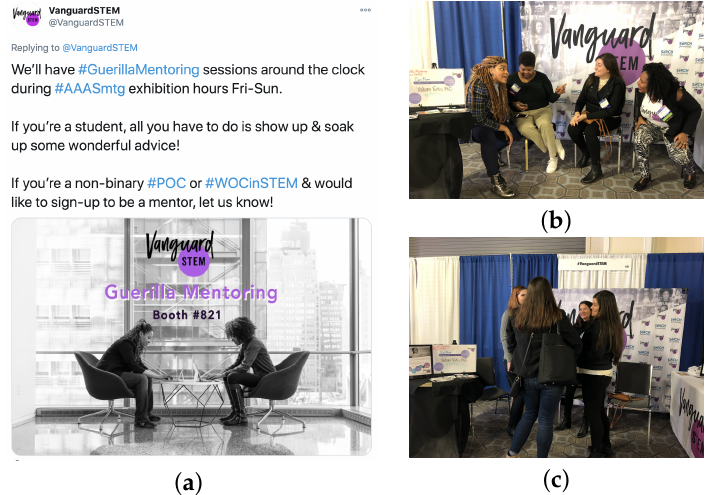
Figure 4. Core to the Conference Crashing initiative is Guerilla Mentoring, where we call upon our community of established women and non-binary people of color in STEM to mentor in-situ and in real-time emerging scholars in the central exhibit hall of a STEM conference. On the left ( a ) we show the call on social media to solicit mentors during the conference and on the right are two examples of ( b ) the sessions of Guerilla Mentoring that resulted from it. These opportunities to connect in STEM professional settings often lead to an immediate sense of belonging, camaraderie and joy ( c